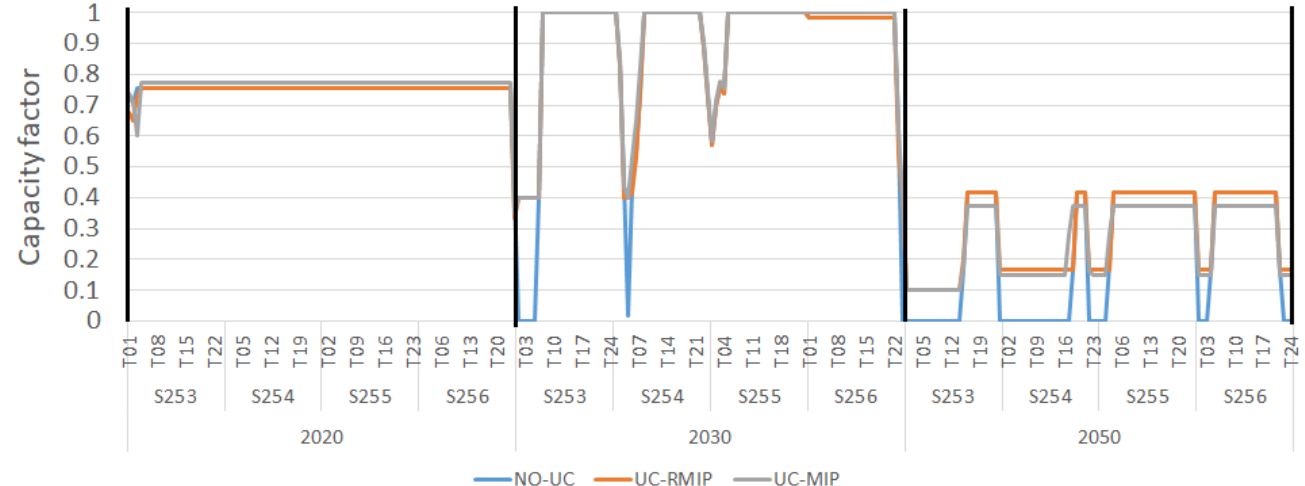
Figure 10. Hourly capacity factor of nuclear power in four consecutive days in Great Britain in different scenario years. The installed capacity in Great Britain of nuclear power is 8.9, 10.2 and 3.2 GW in 2020, 2030, and 2050, respectively. The impact of the UC modelling approach.